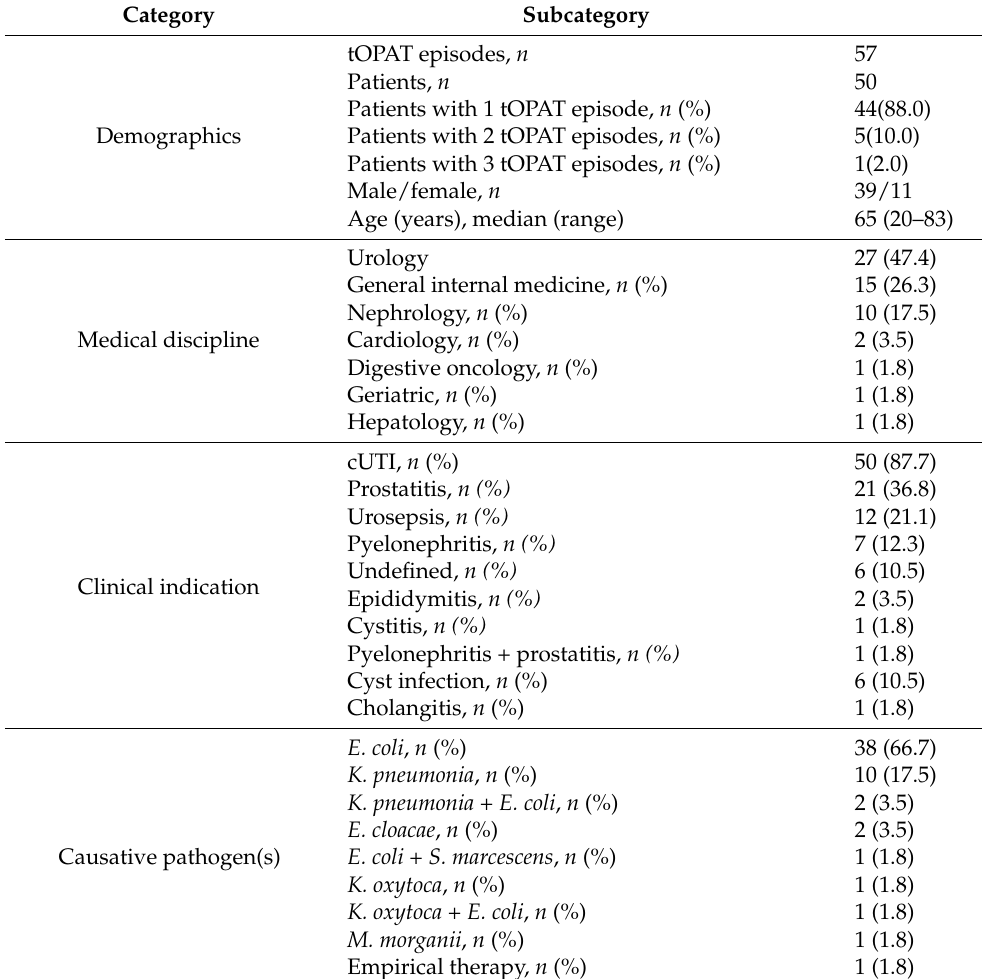
Table 1. Summary of demographic, clinical and treatment-related data of all the included tOPAT episodes ( n =